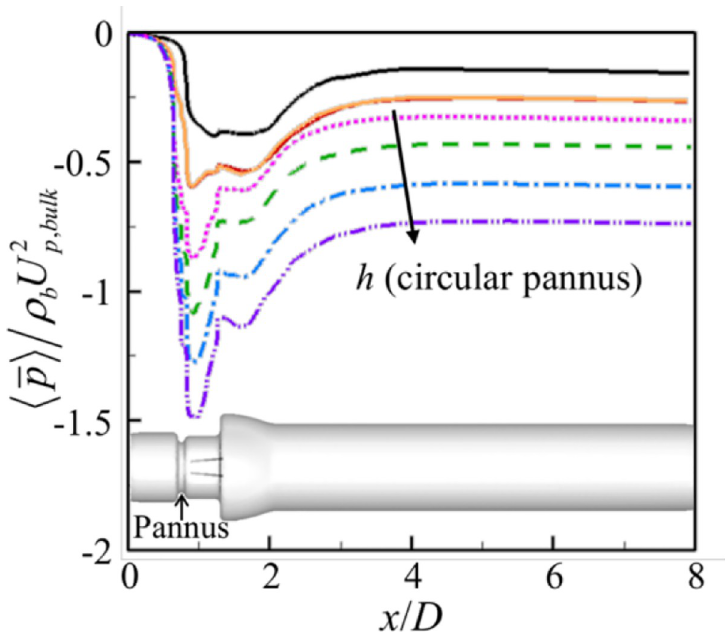
■■■ , circular pannus ( h / D = 0.11); ▬▬▬ , circular pannus ( h / D = 0.12); ▬■▬ , circular pannus ( h / D = 0.13); ▬■■▬ , circular pannus ( h / D = 0.14).